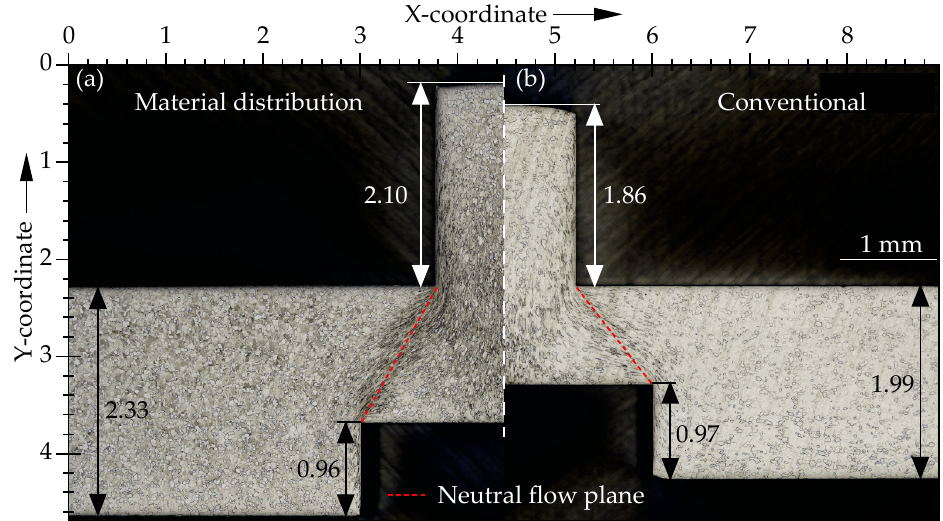
Figure 9. Comparison of the ( a ) material distribution and ( b ) conventional pin extrusion by means of micrographs of the pin structure and the forming zone.